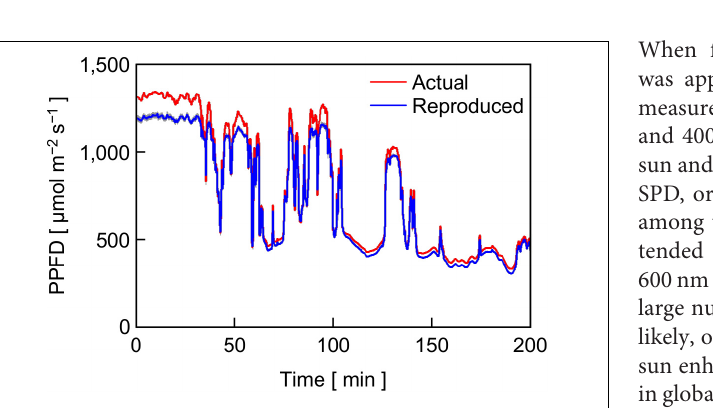
FIGURE 4 | Time course of PPFD of actual sunlight measured in Bunkyo, Tokyo, Japan (35 ◦ 43’N) from 11:10 to 14:30 on October 12, 2017 and that of sunlight reproduced with the LASS system. The height of gray area at a given time represents the standard deviation of the PPFD of the reproduced sunlight ( n =